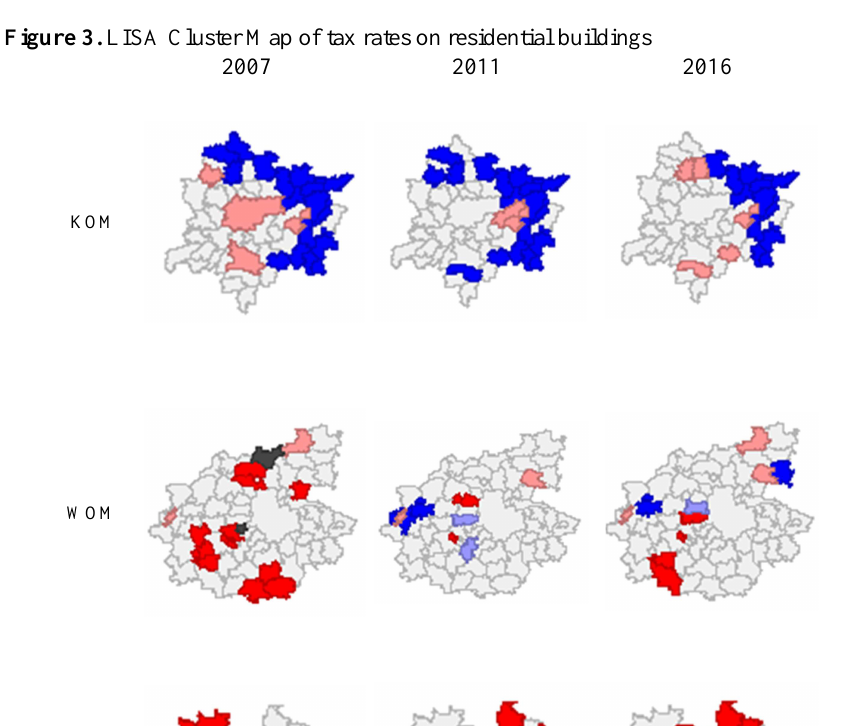
Figure 3. LISA Cluster Map of tax rates on residential